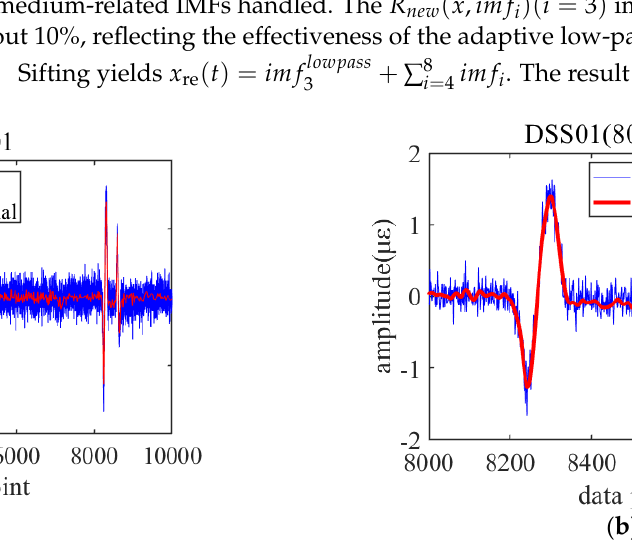
Figure 15. Signal sifting: ( a ) DSS01, ( b ) DSS01 (8000-9000). The 8000-9000 fragment of DSS-01-1 is intercepted as Figure 15b. The traffic load signal is smooth without obvious noise interference in this fragment, and without median filtering processing, the peak feature information of the effective signal is better. The results show that the OREMD sifting yields accurate traffic load information. DSS-02 and DSS-03 are located near the main lane in the cross-bridge direction, so traffic signal amplitude is greater compared to noise, which means the high signal-to-noise ratio. The sifting results are shown as Figure 16. Due to the high signal-to-noise ratio of the original signal, the sifted signal is accurate and more reliable, and the peak weakening is